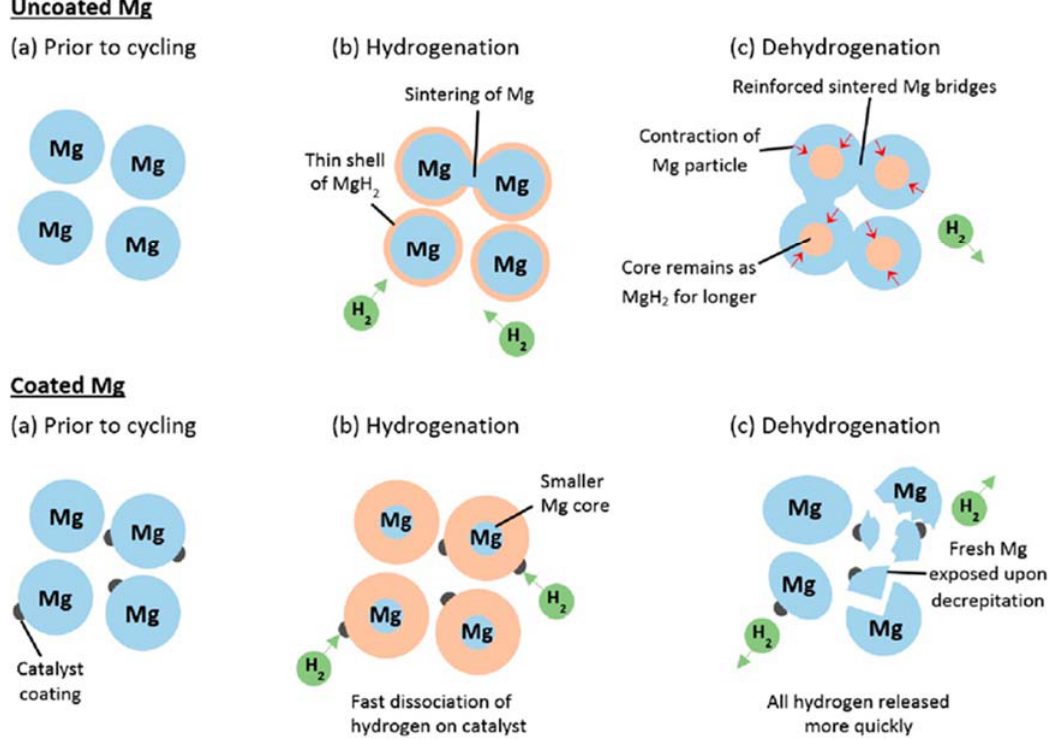
Figure 4. Illustrations of different proposed mechanisms for the evolution of uncoated Mg and coated Mg samples, ( a ) prior to cycling, ( b ) the onset of hydrogenation, and ( c ) during dehydrogenation. Reproduced with permission from [57], Copyright Elsevier, 2017.